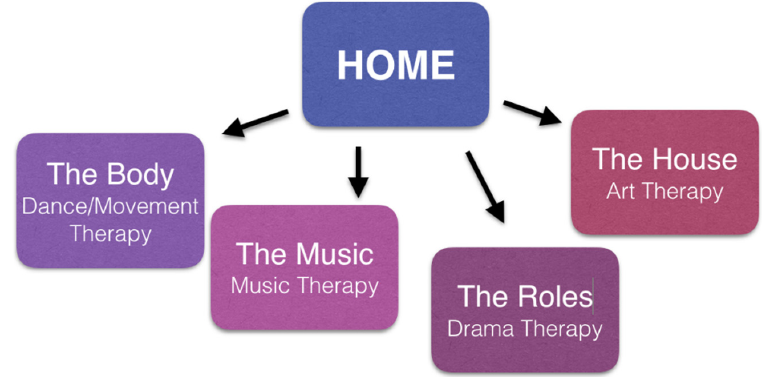
Figure 1. Home and the Creative Arts Therapies.